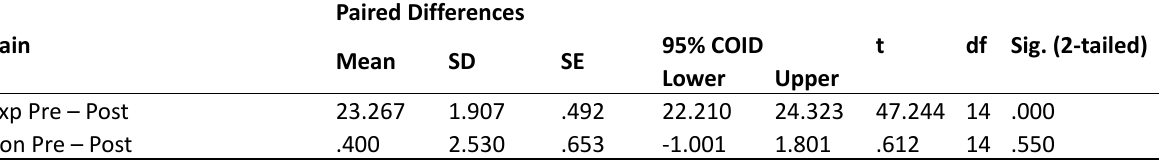
Error Mean CIOD= Confidence Interval of the difference Table 2. Pre and post mean differences of experimental and control group for concentration